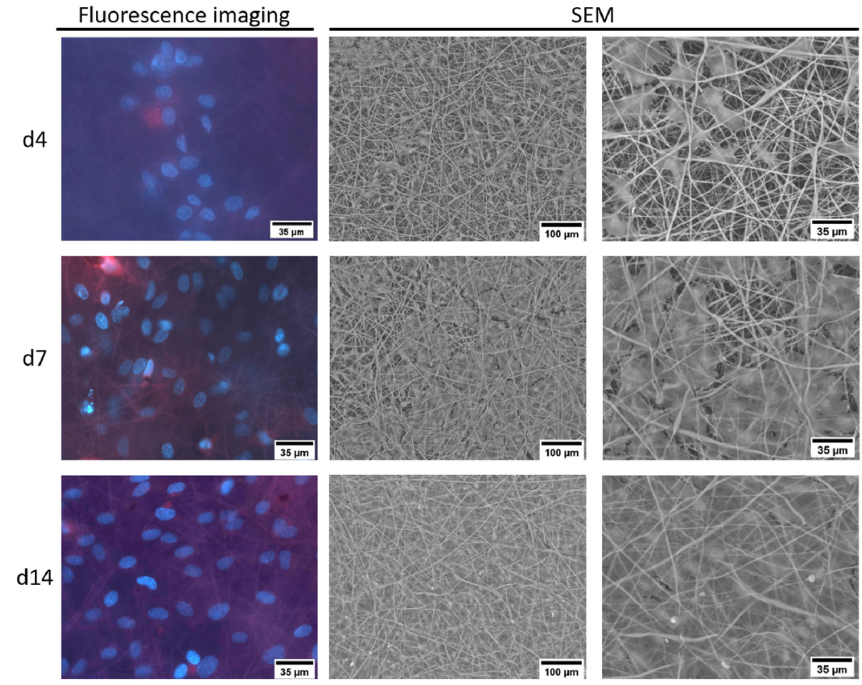
Figure 7. Representative SEM and fluorescence microscopy images of uncoated PCL tissues (700 nm fiber size) seeded with ECFCs for 4, 7, and 14 days.